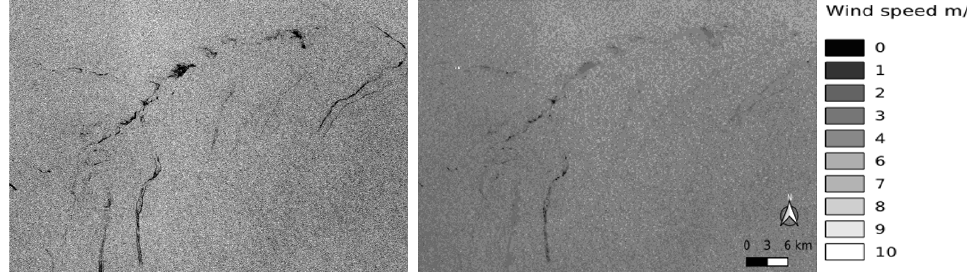
Figure 8. Illustration of the wind information associated with the SAR image on 21 January 2020 in the Nigeria area. The SAR image with slicks and lookalike phenomena on the left, on the right, the associated wind speed data.